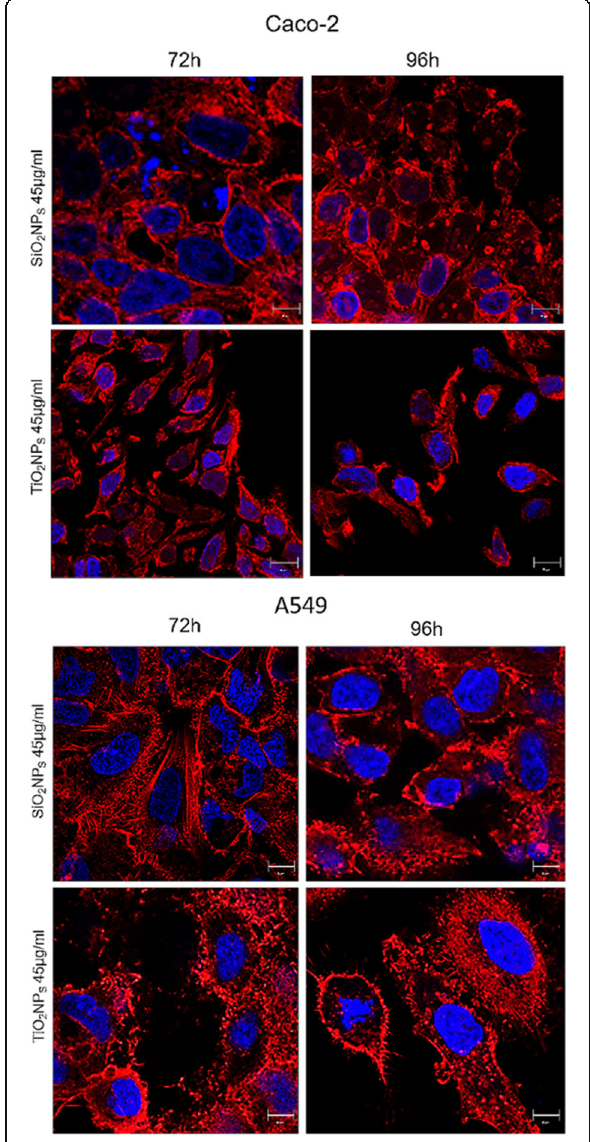
Fig. 8 Local enlargement of confocal acquisitions acquired in Figs. 6 and 7 showed (more in details) the effect of SiO 2 NPS and TiO 2 NPs on actin network of Caco-2 and A549 cells after the exposure of 45 μ g/ml of NPs for 72 h and 96